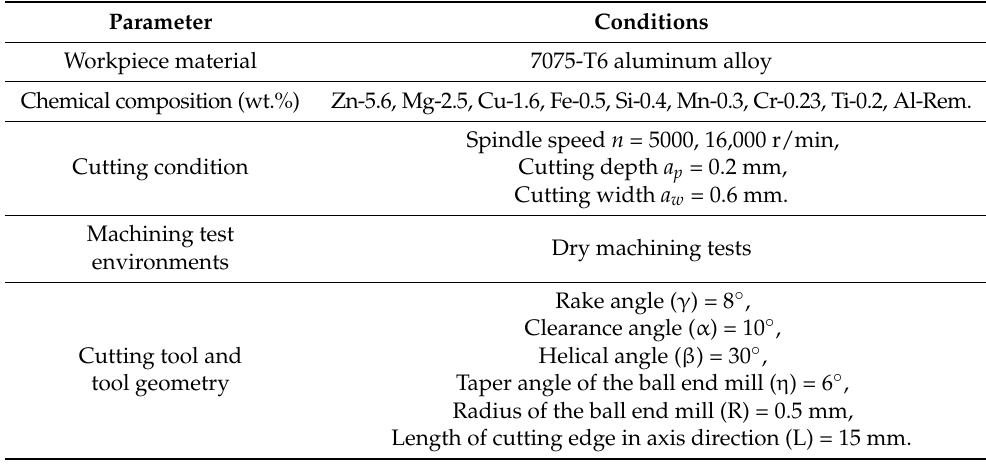
Table 3. Conditions adopted in FE simulation and machining experiment.